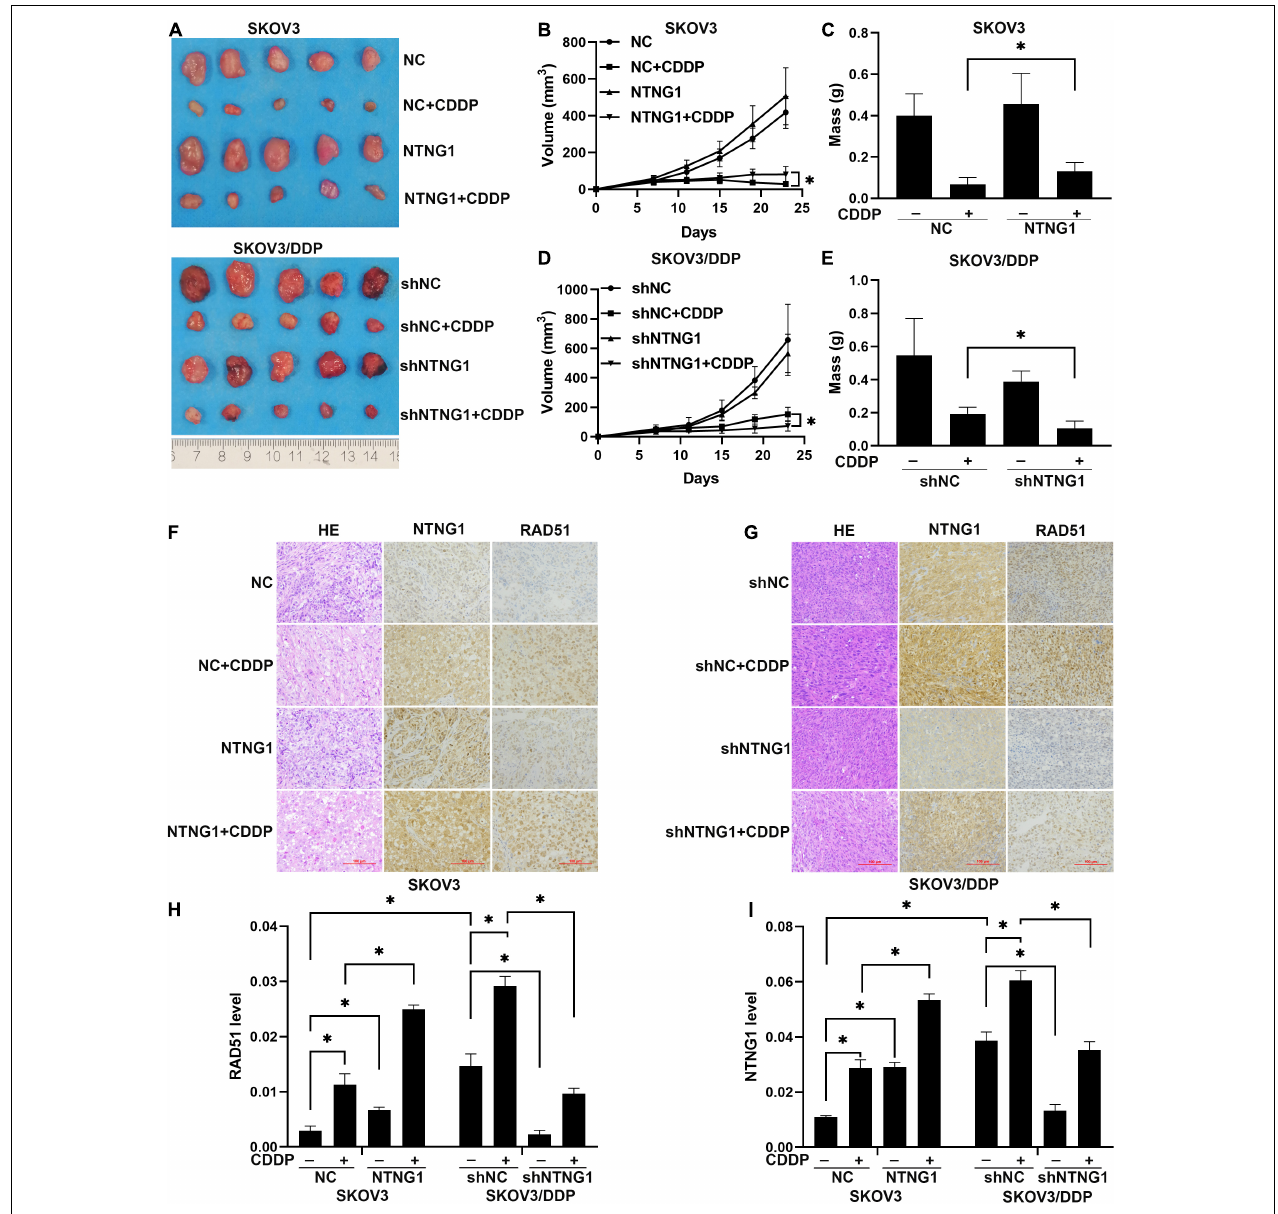
FIGURE 6 | NTNG1 modulated the action of cisplatin in xenograft tumors ( n = 5). (A) Image of SKOV3 and SKOV3/DDP tumors. (B,C) Volume and mass of SKOV3 tumors; values in group NTNG1 + CDDP were greater than those in group NC + CDDP, indicating a decrease in antitumor efficacy. (D,E) Volume and mass of SKOV3/DDP tumors; values in group shNTNG1 + CDDP were less than those in group shNC + CDDP, demonstrating a stronger anticancer action. (F,G) Immunohistochemical images of NTNG1 and RAD51 proteins in tumor tissues; scale = 100 µ m. (H,I) Levels of NTNG1 and RAD51 proteins; cisplatin treatment induced the expression of RAD51; in SKOV3 tumors, levels of NTNG1 and RAD51 in group NTNG1 + CDDP were higher than those in group NC + CDDP; in SKOV3/DDP tumors, lower levels were detected in group shNTNG1 + CDDP compared with group shNC + CDDP. CDDP, cisplatin. ∗ p <